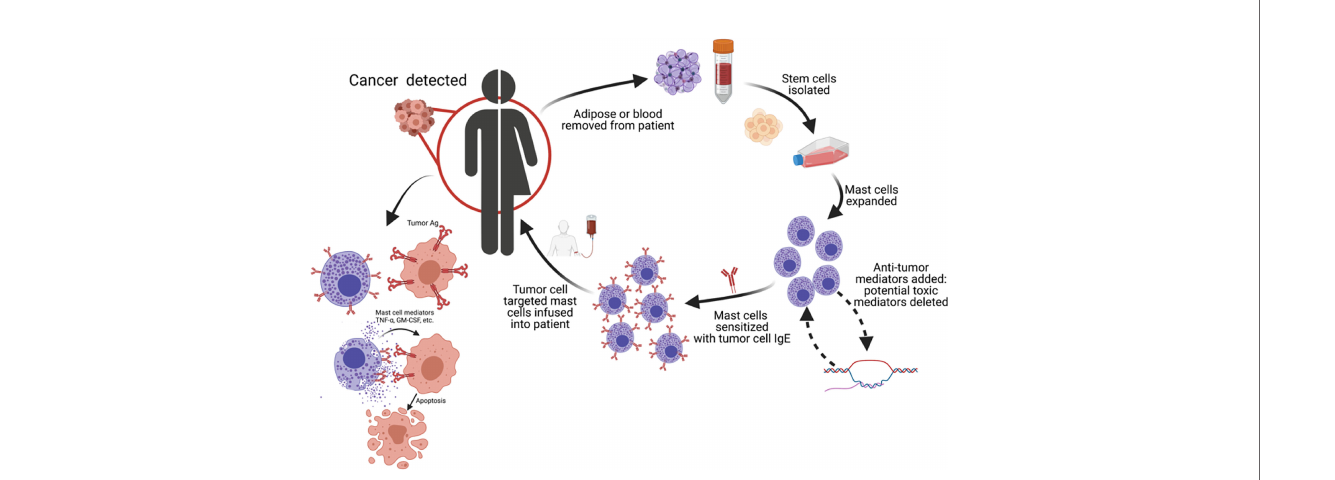
FIGURE 2 | Autologous MC cancer immunotherapy; a potential new platform for cancer therapy. We propose using MCs as a new cell type for adoptive cell transfer for cancers in which tumor-speci fi c IgE ’ s are available. MC progenitors are obtained from patient, MCs expanded and polarized to enhance cytotoxicity and/or minimize systemic toxicity, and re-polarized MCs reinfused into